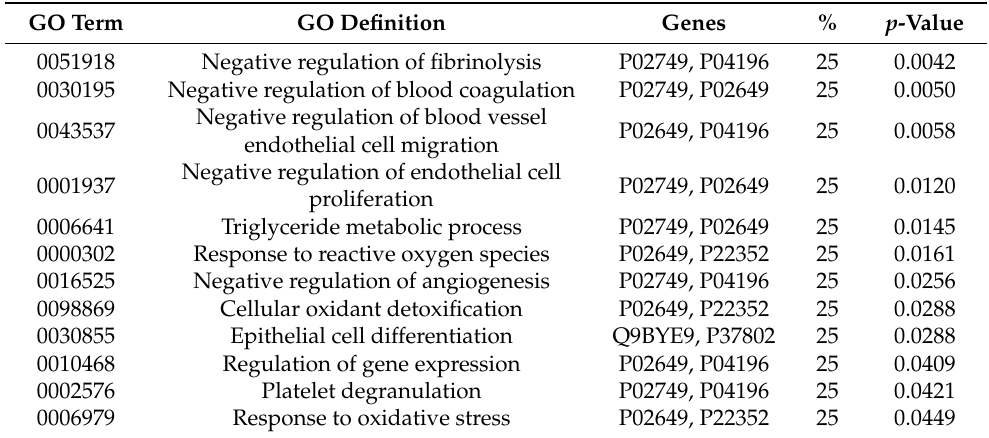
Table 2. Gene Ontology analysis of de-regulated proteins with statistically significant differences between PRGF vs PRGF